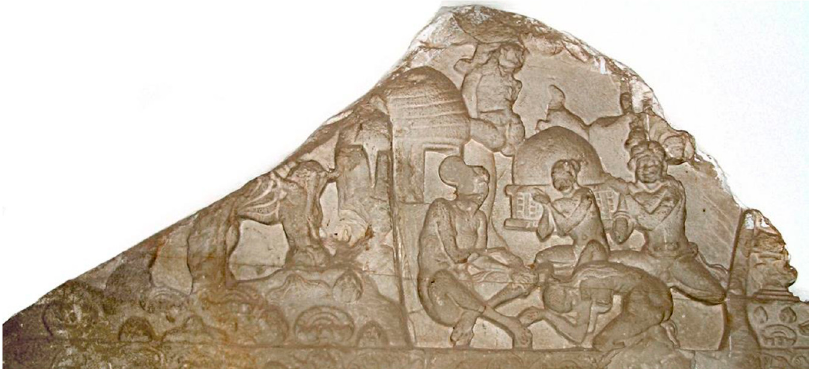
Figure 10. Amaravati, Chennai Government Museum, no. 54 © photograph Monika Zin.